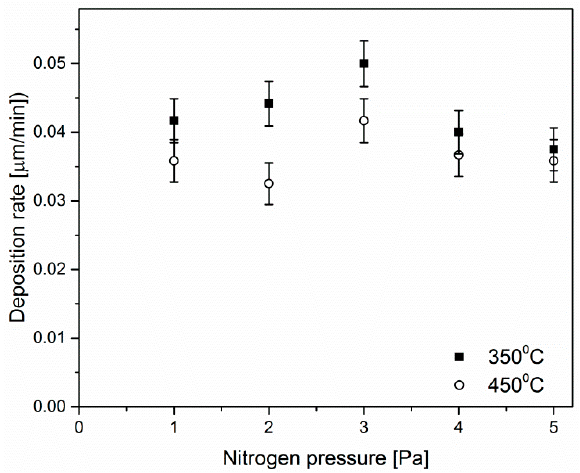
Figure 2. Deposition rates of AlCrN coatings formed at 350 and 450 °C.